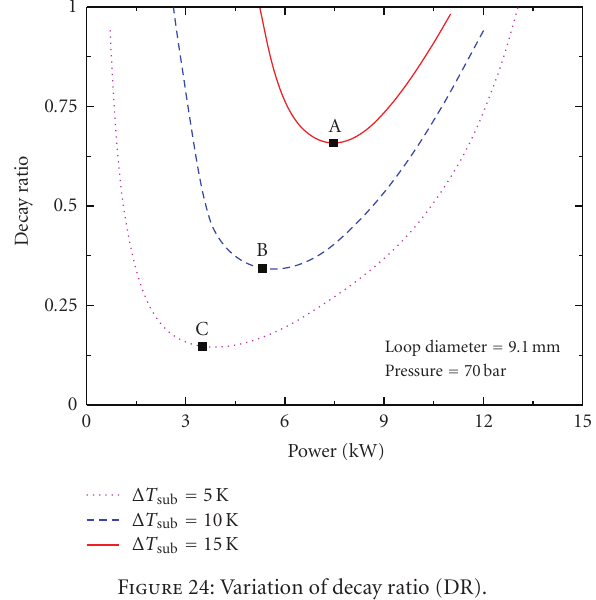
Figure 24: Variation of decay ratio (DR).